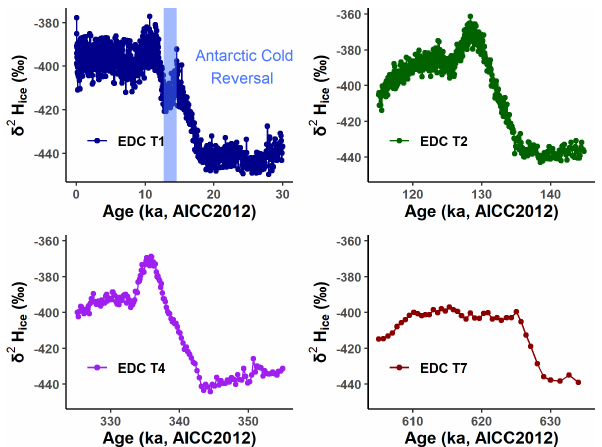
Figure C1. δ 2 H ice records from EDC. δ 2 H ice records for T1, T2, T4, and T7 on the AICC2012 scale are from Bazin et al. (2013b). The blue vertical bar represents the time interval of the ACR